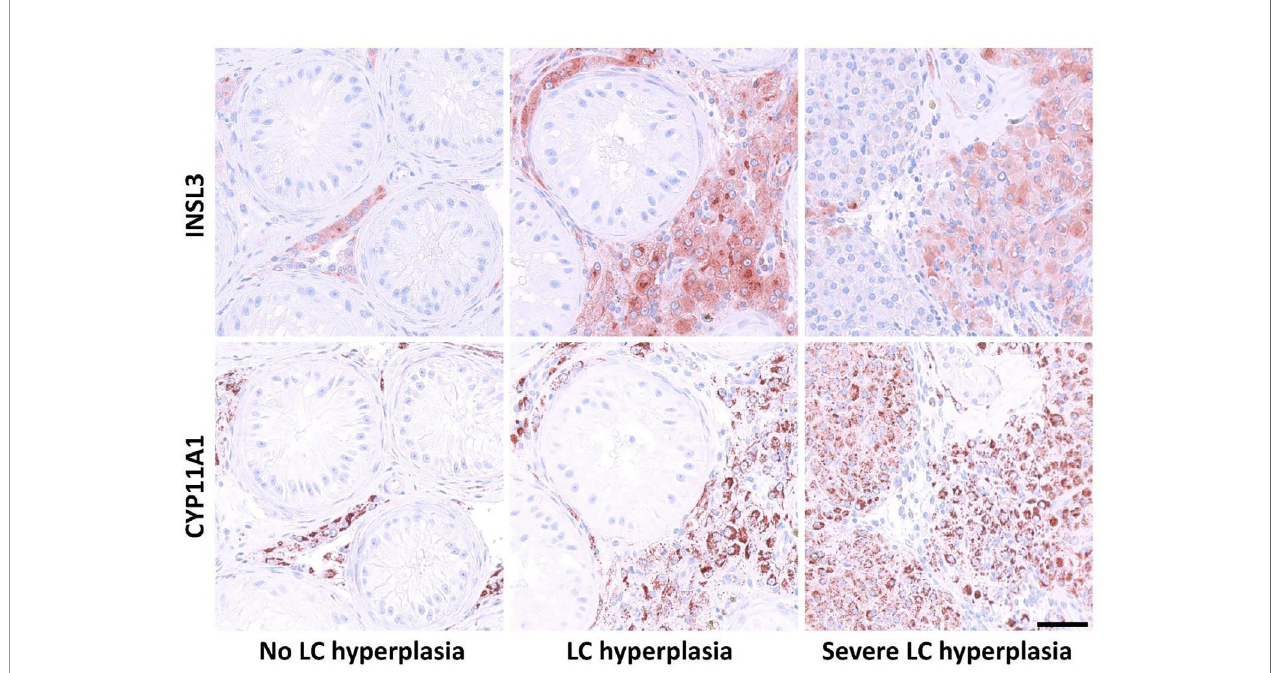
FIGURE 3 | Expression pattern of Insulin-like factor 3 (INSL3) and cytochrome P450 Family 11 Subfamily A Member 1 (cholesterol side-chain cleavage enzyme, CYP11A1), in biopsies or gonadectomies from male patients with 45,X/46,XY mosaicism. Column 1: expression of INSL3 and CYP11A1 in samples without presence of Leydig cell (LC) hyperplasia. Column 2: expression pattern in areas with LC hyperplasia. Column 3: INSL3 and CYP11A1 expression in areas with severe LC